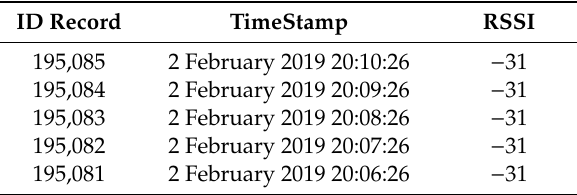
Table 4. Examples of output variables for